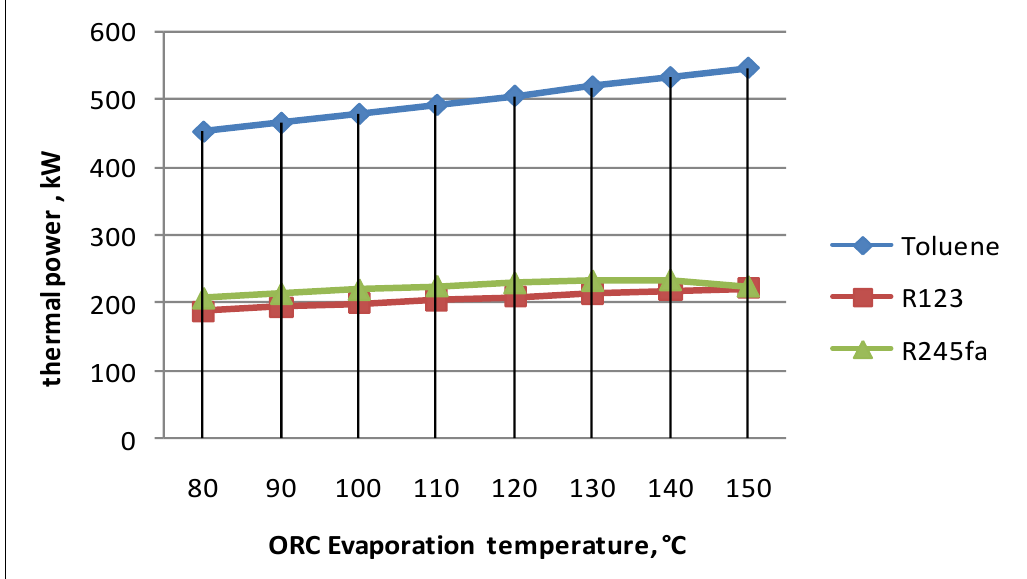
Figure 3. Variation of thermal power of evaporator with ORC evaporation temperature according to the studied working